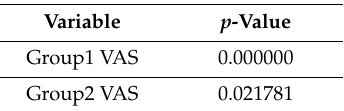
Table 12. Results of sign tests.